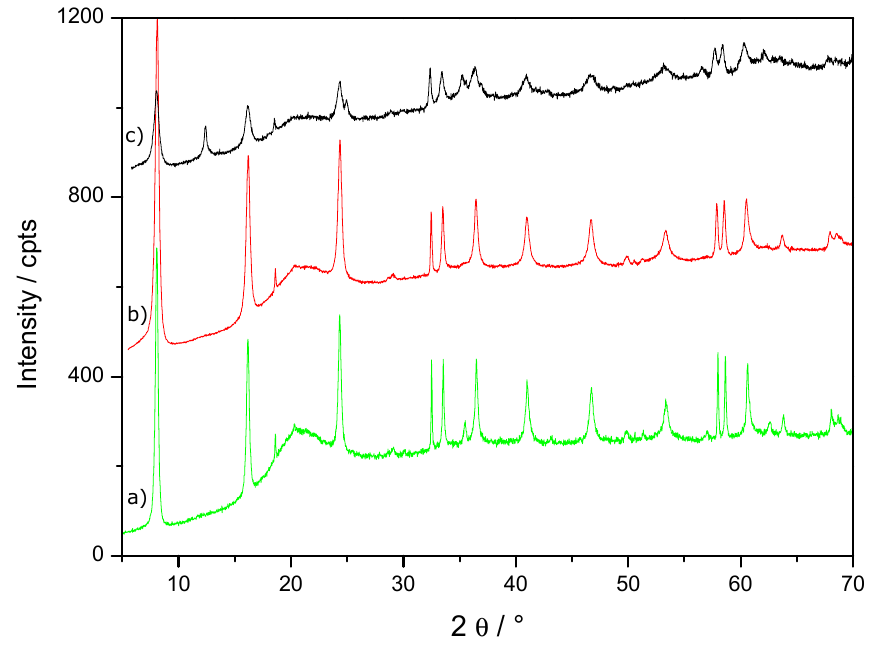
Figure 3. XRD patterns of ( a ) R06I (green), ( b ) R06B02I (red), ( c ) R06B05I (black) samples.